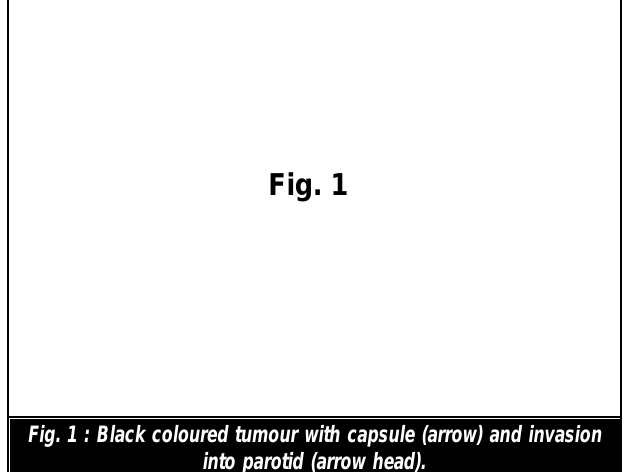
Fig. 1 : Black coloured tumour with capsule (arrow) and invasion into parotid (arrow